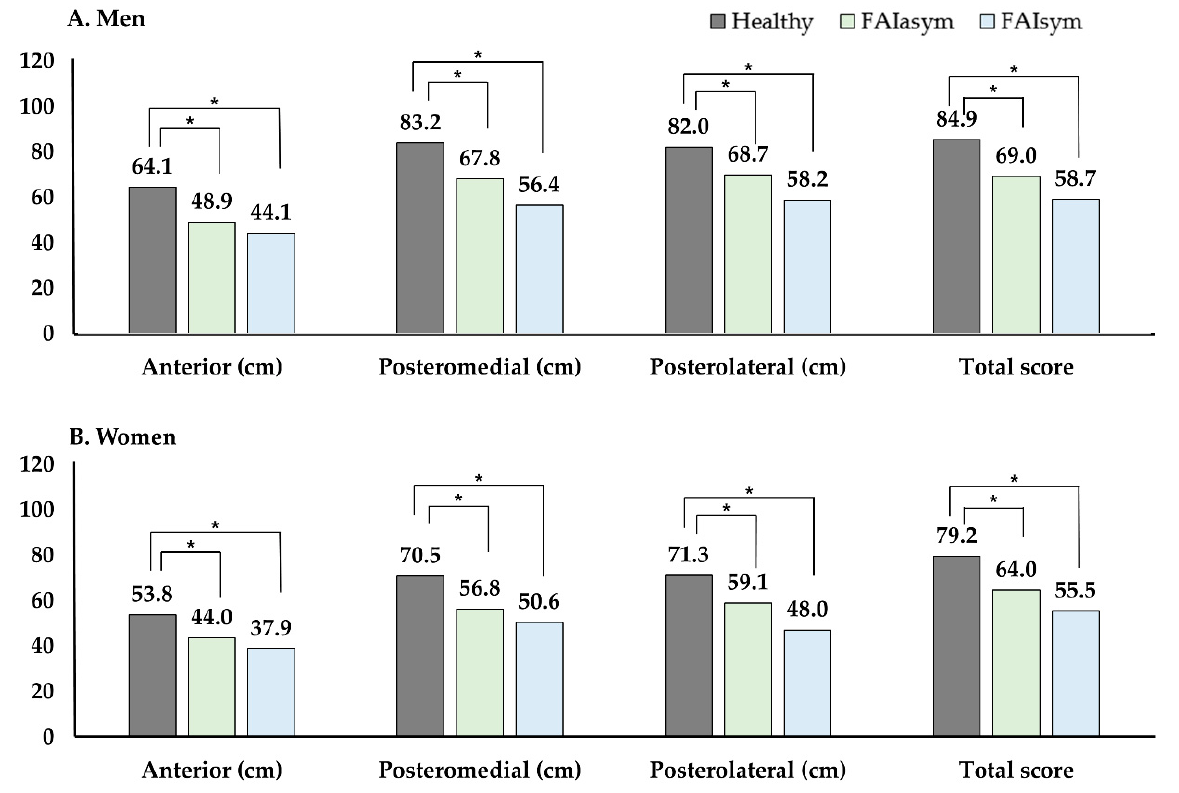
Figure 3. Comparison of Y-balance test in healthy, asymptomatic and symptomatic femoroacetabular impingement patients. * p < 0.05, significance. Abbreviations: FAI, femoroacetabular impingement; sym, symptomatic; asymptomatic, asymptomatic.